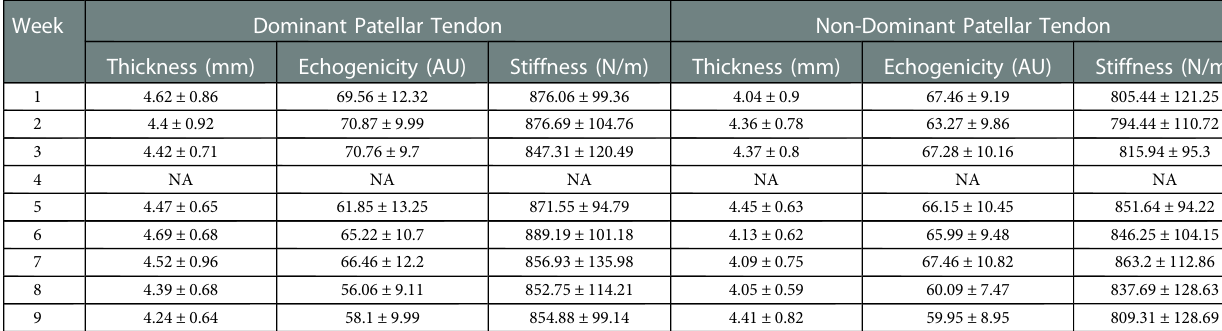
TABLE 1C Descriptive Statistics - Weekly Patellar Tendon